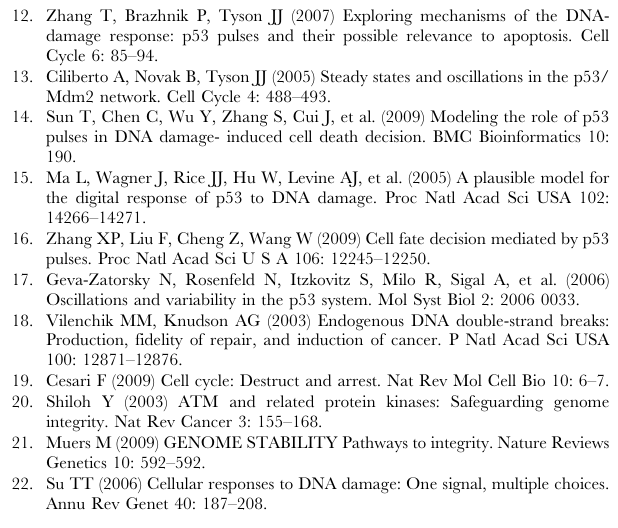
Figure S1 Bifurcation diagram. Stable steady state (black solid curve), unstable steady state (dashed curve) and amplitude (violet) are shown. Red curve is a guide for the parameter value used in our model. Figure S2 Distribution of the interspike intervals displays significant variations. The total number of stochastic runs is 200.